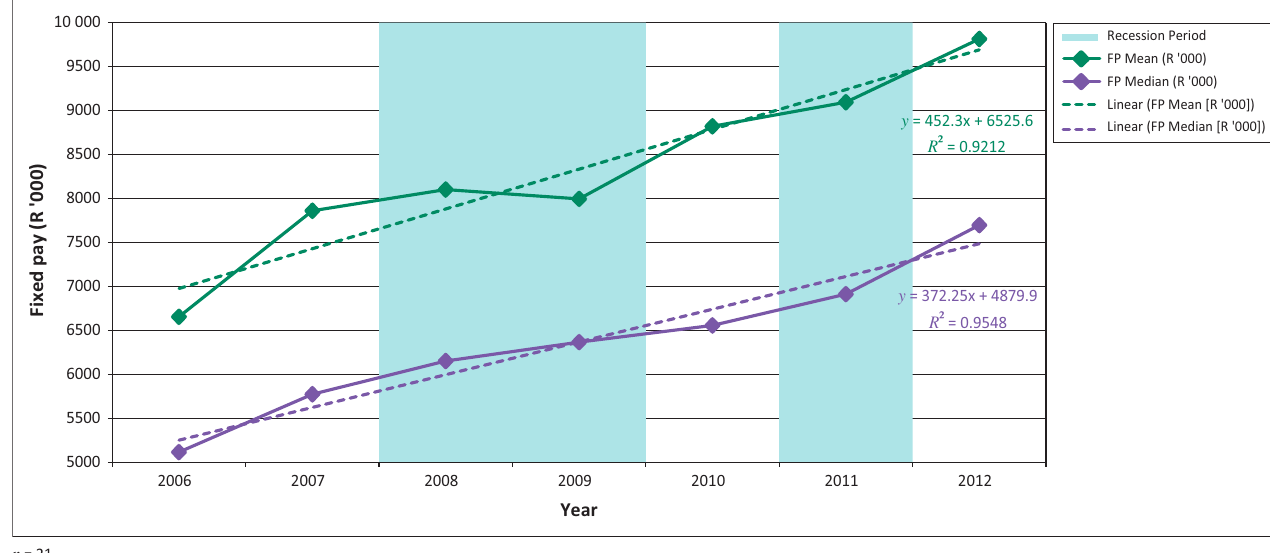
y = 452.3x + 6525.6 R ² = 0.9212